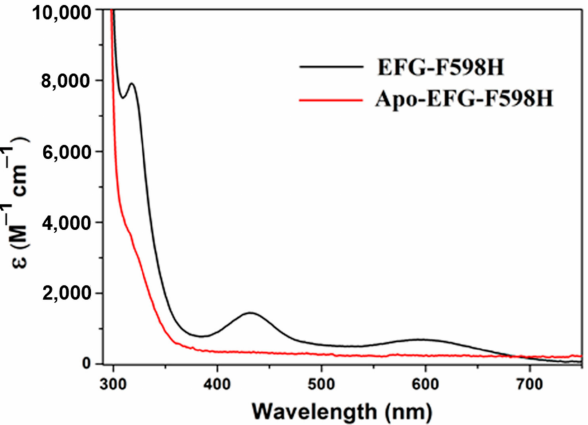
Figure 3. UV-Vis spectra of apo-EFG-F598H (red) and Ni reconstituted EFG-F598H